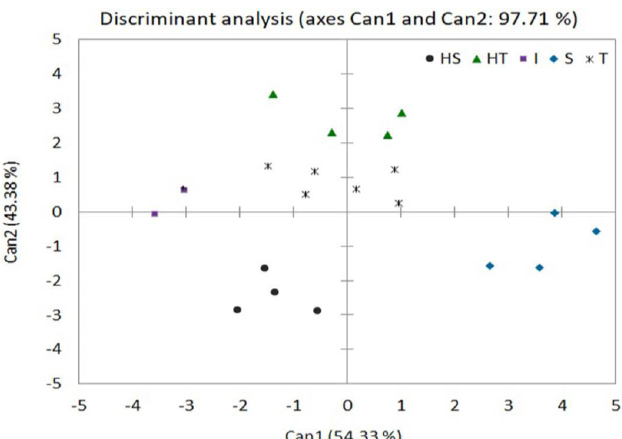
Figure 6. Distribution of 20 wheat genotypes by discriminant analysis of grain-filling duration, canopy temperature, spike length, and grain yield indices. Highly tolerant (HT), tolerant (T), intermediate (I), sensitive (S), and highly sensitive (HS).